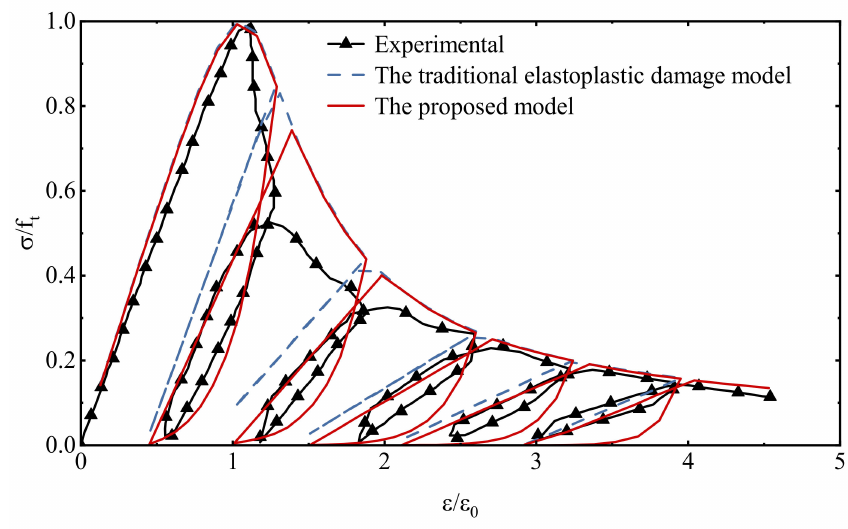
Figure 11. Comparison of stress–strain relationship under uniaxial cyclic tensile loading.